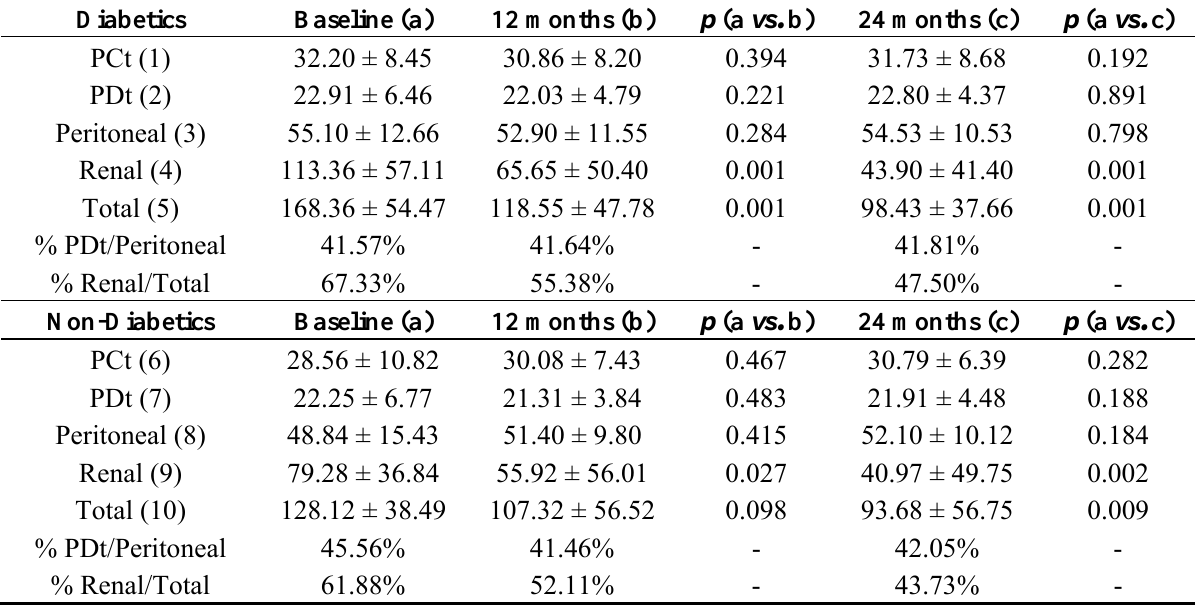
Table 5. Creatinine clearance (L/week/1.73 m 2